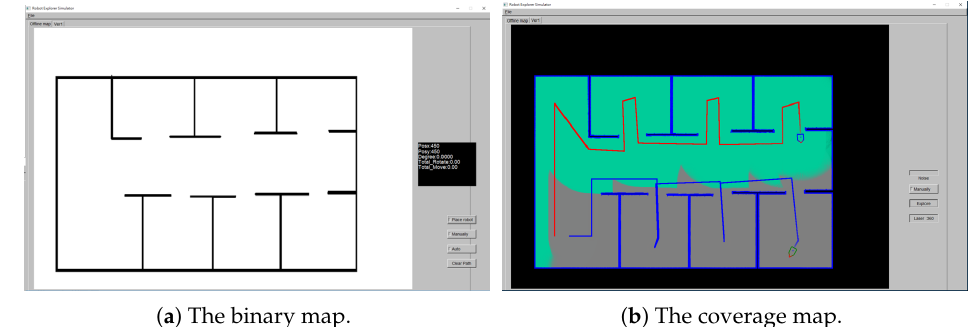
Figure 2. The application interface of the complete coverage and path planning simulation environ- ment used for the multi-robot exploration.